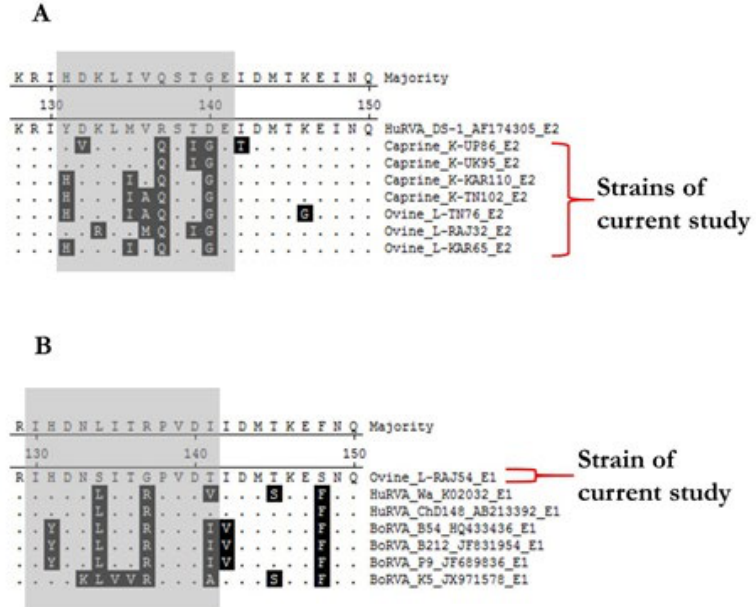
Fig. 2. Alignment of an interspecies variable domain (ISVD) of NSP4 from the current study and reference isolates. (A) Alignment depicts the amino acid sequence variation in E2 type strains (B) Alignment depicts the amino acid sequence variation in E1 type strains. Variable residues have been highlighted in black colour showing variance in